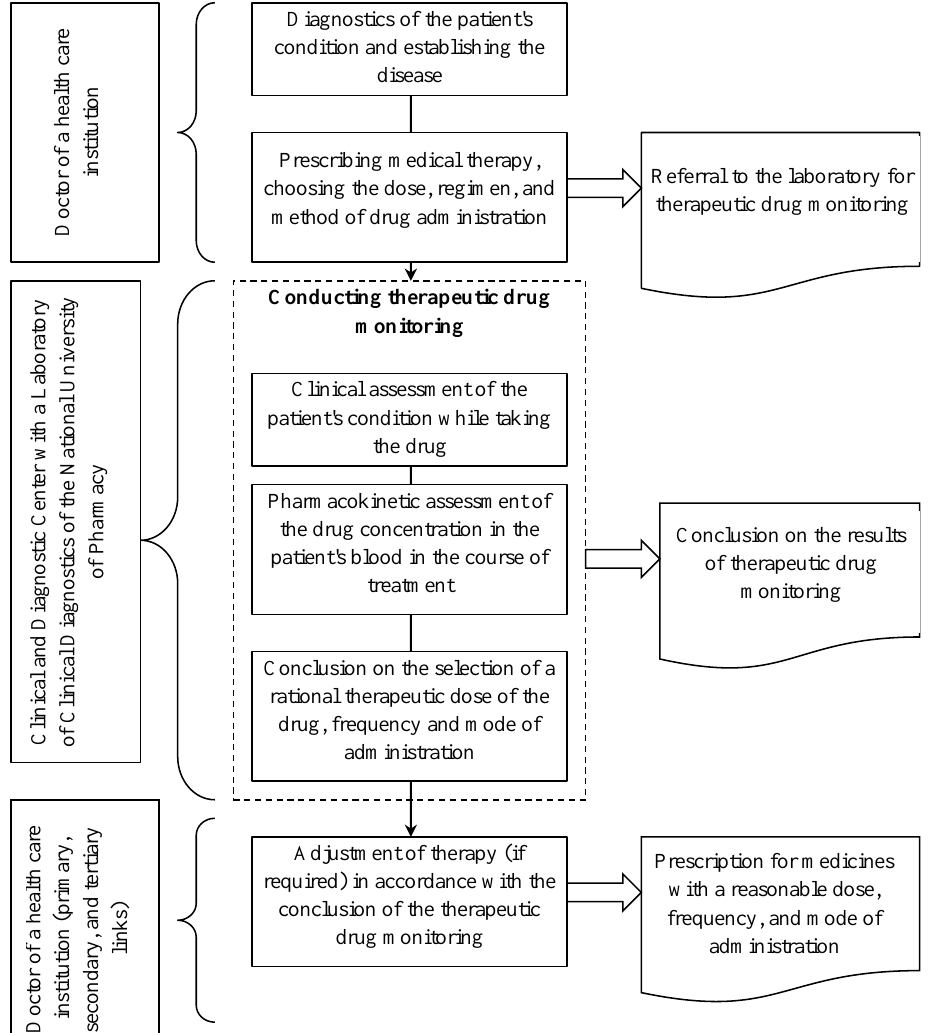
Fig. 2. Flowchart of the research center interaction with a health care institution during the implementation of TDM using north-eastern region of Ukraine as a case study To ensure the effective promotion of the concep- tual framework of evidence-based medicine